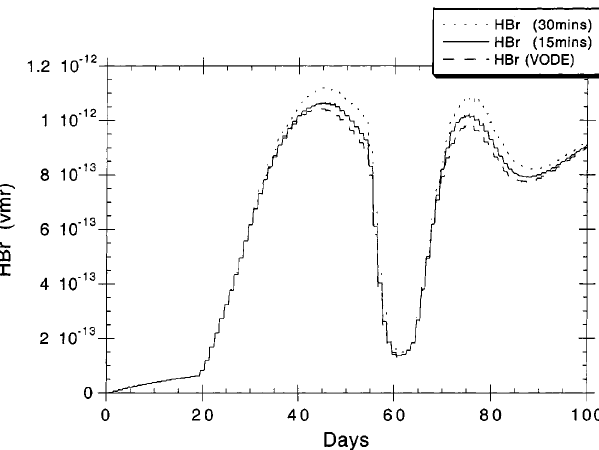
Fig. 7. The di(cid:128)erence between the concentration of a short-lived species, HBr, for the VODE run ( long dashed curve ), IMPACT with a 15 min time step ( solid curve ) and 30 min time step ( short dashed curve